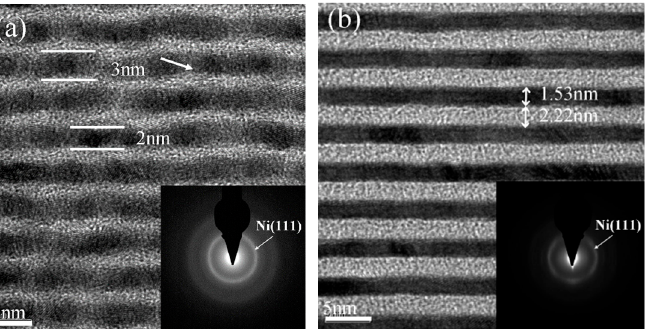
Figure 2. Cross-sectional HRTEM images and SAED patterns (insets) of Ni/C multilayers deposited with ( a ) pure Ar and ( b ) a mixture Ar + 4% N 2 as the working gas.